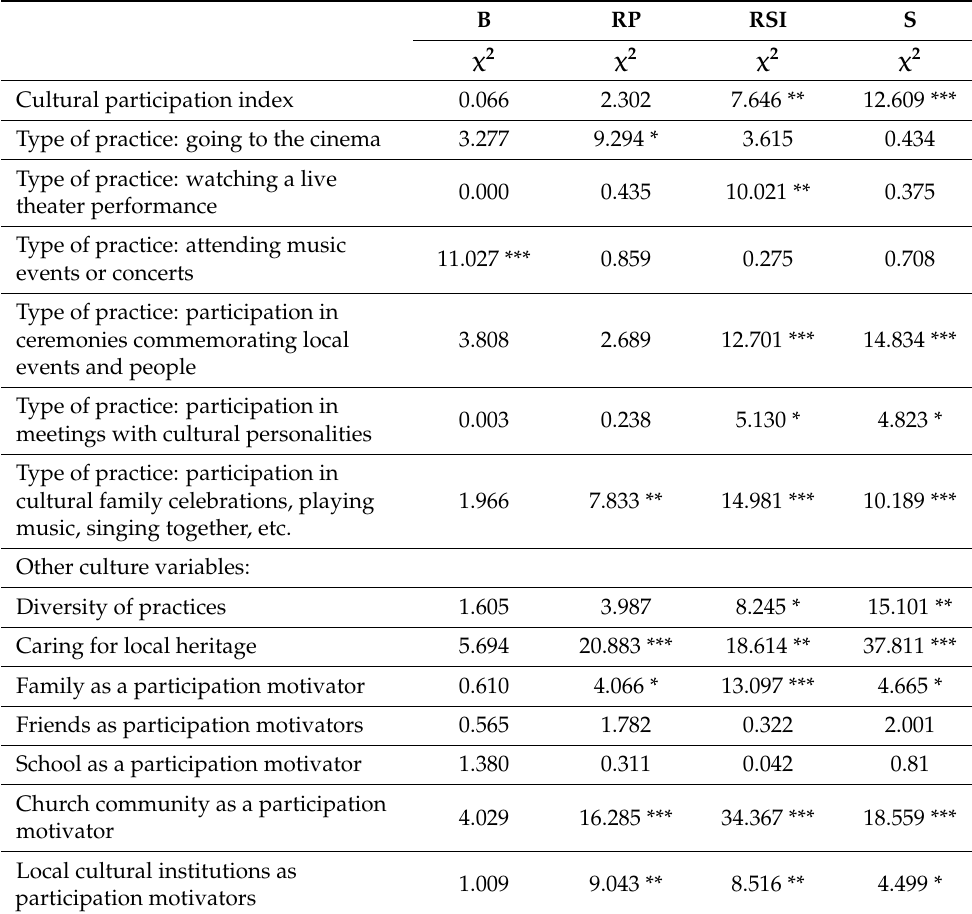
Table 4. Table of